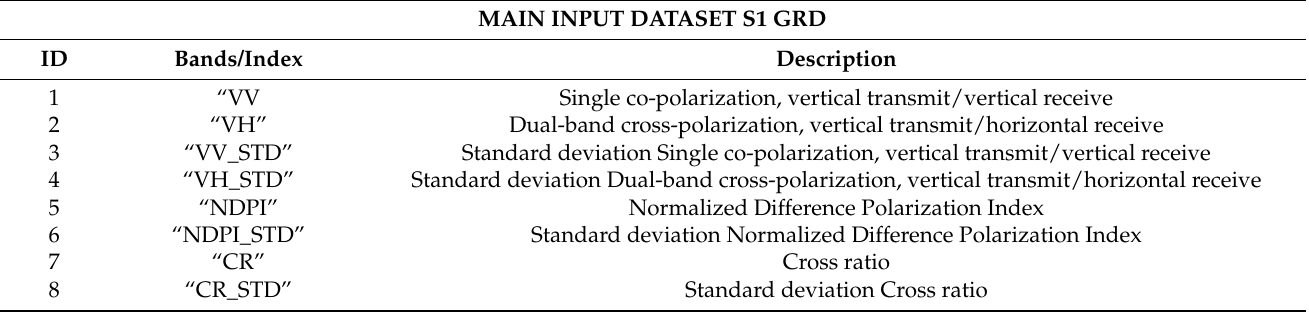
Table 2. SAR Sentinel-1 GRD bands adopted in water